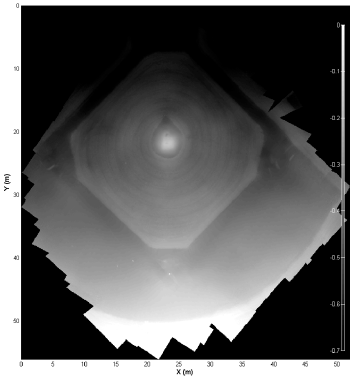
Figure 7. Depth elevation map.